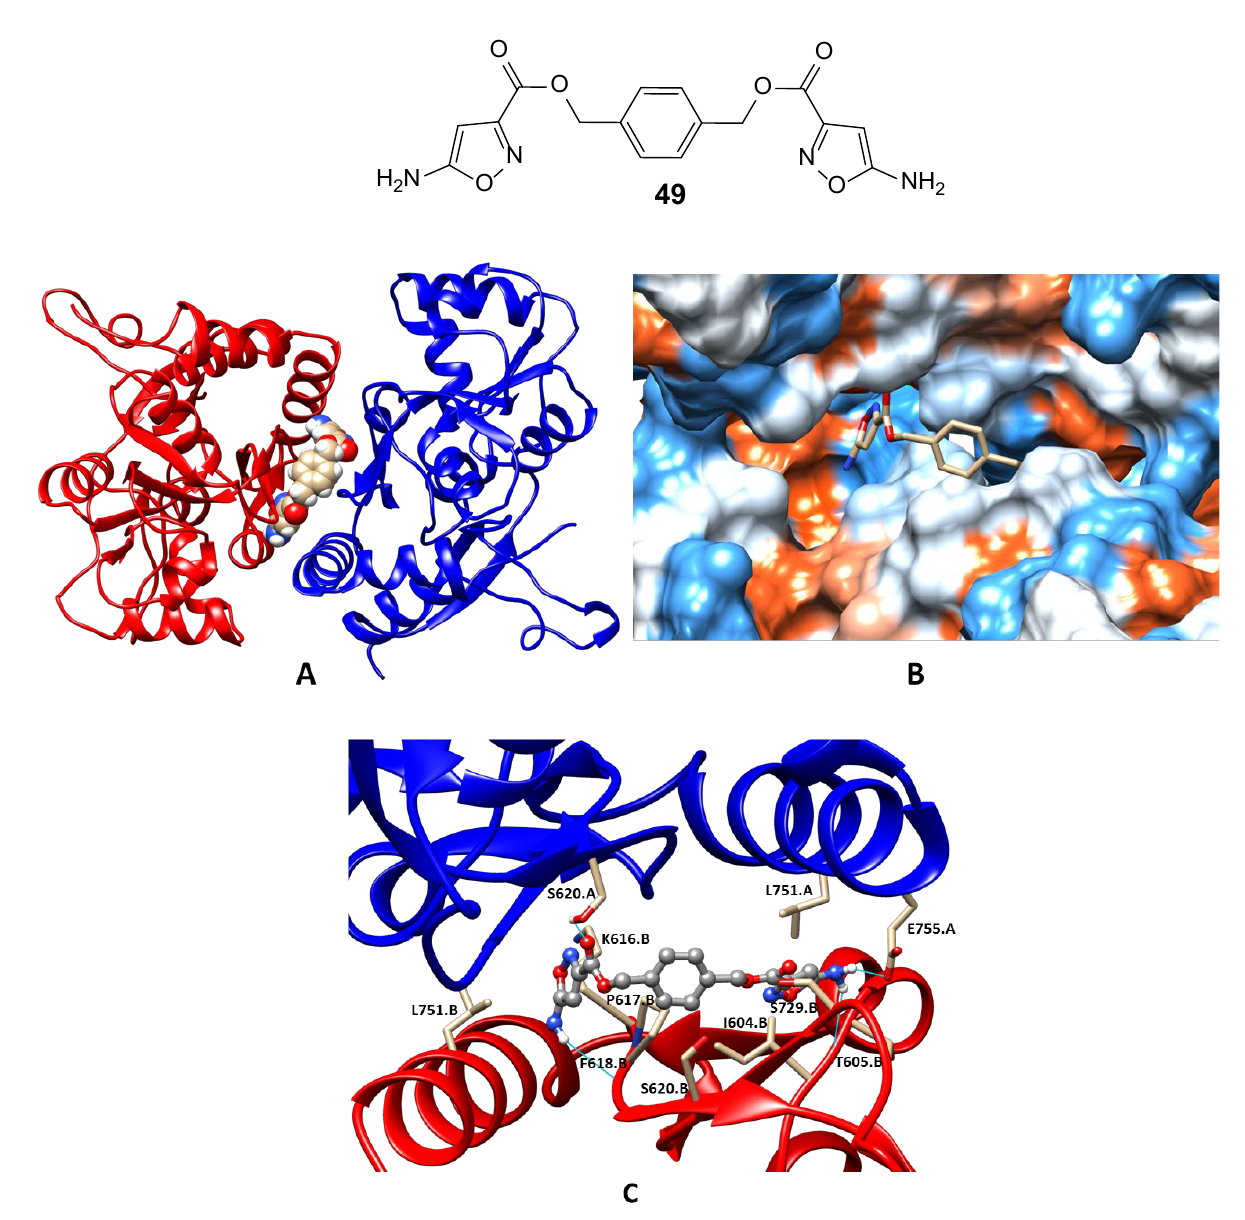
Figure 9. Binding mode of the PAM 49 refined using molecular dynamics simulation. ( A ) General view of the dimeric ligand-binding domain of AMPA receptor (GluA2) and location of the binding site. ( B ) Binding pockets in the protein molecular surface colored by local hydrophobicity (brown for hydrophobic and blue for hydrophilic). ( C ) Detailed view of the binding site. The ligand is represented by a grey ball-and-stick model, the amino acid residues located within 3 Å of it are represented by beige stick models. Hydrogen bonds are shown as cyan lines.